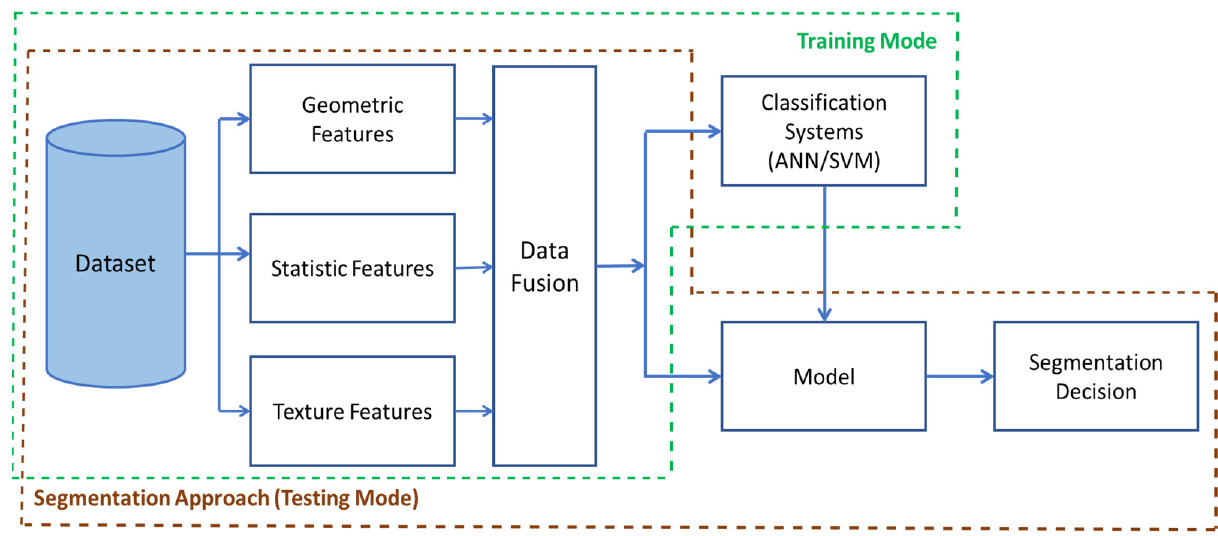
Figure 5. The Segmentation Diagram Block of the first strategy in Nosema detection: The Training Mode consists of the part of dataset construction, features extraction, and their fusion to be trained with ANN and SVM. The Testing Mode consists of data preparation for testing the model and decision making.